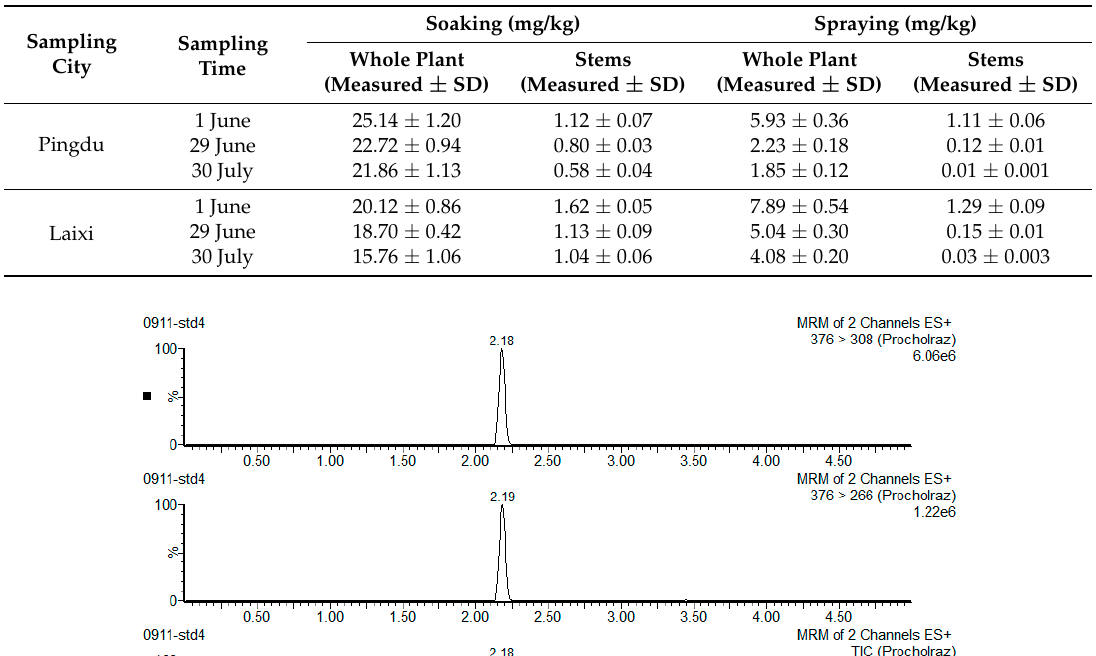
Table 4. Actual samples of prochloraz residue after soaking and spraying treatment ( n = 3).